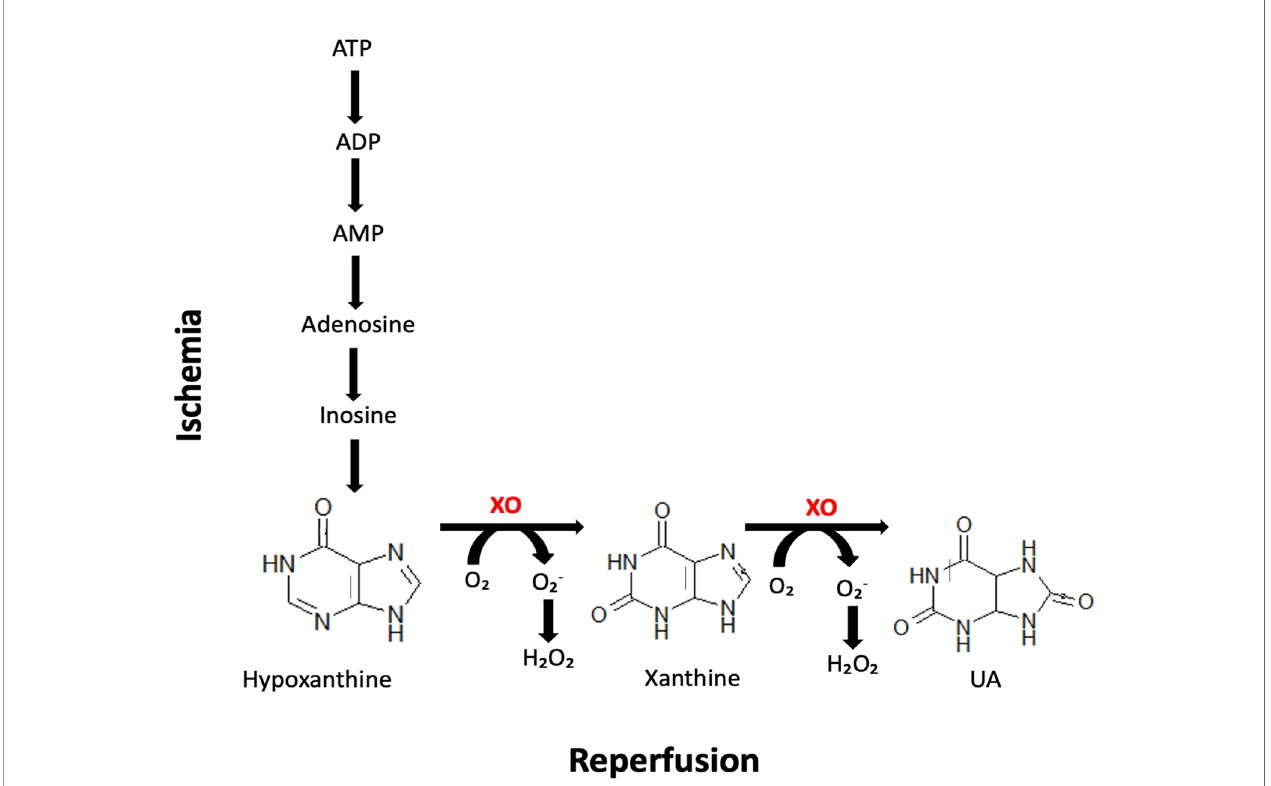
FIGURE 1 | Biochemical reactions occurring in the stroke brain during ischemia and reperfusion. Xanthine oxidase (XO) catalyzes the conversion of hypoxanthine to xanthine and xanthine to uric acid (UA), generating high amounts of superoxide radicals and hydrogen peroxide (H 2 O 2